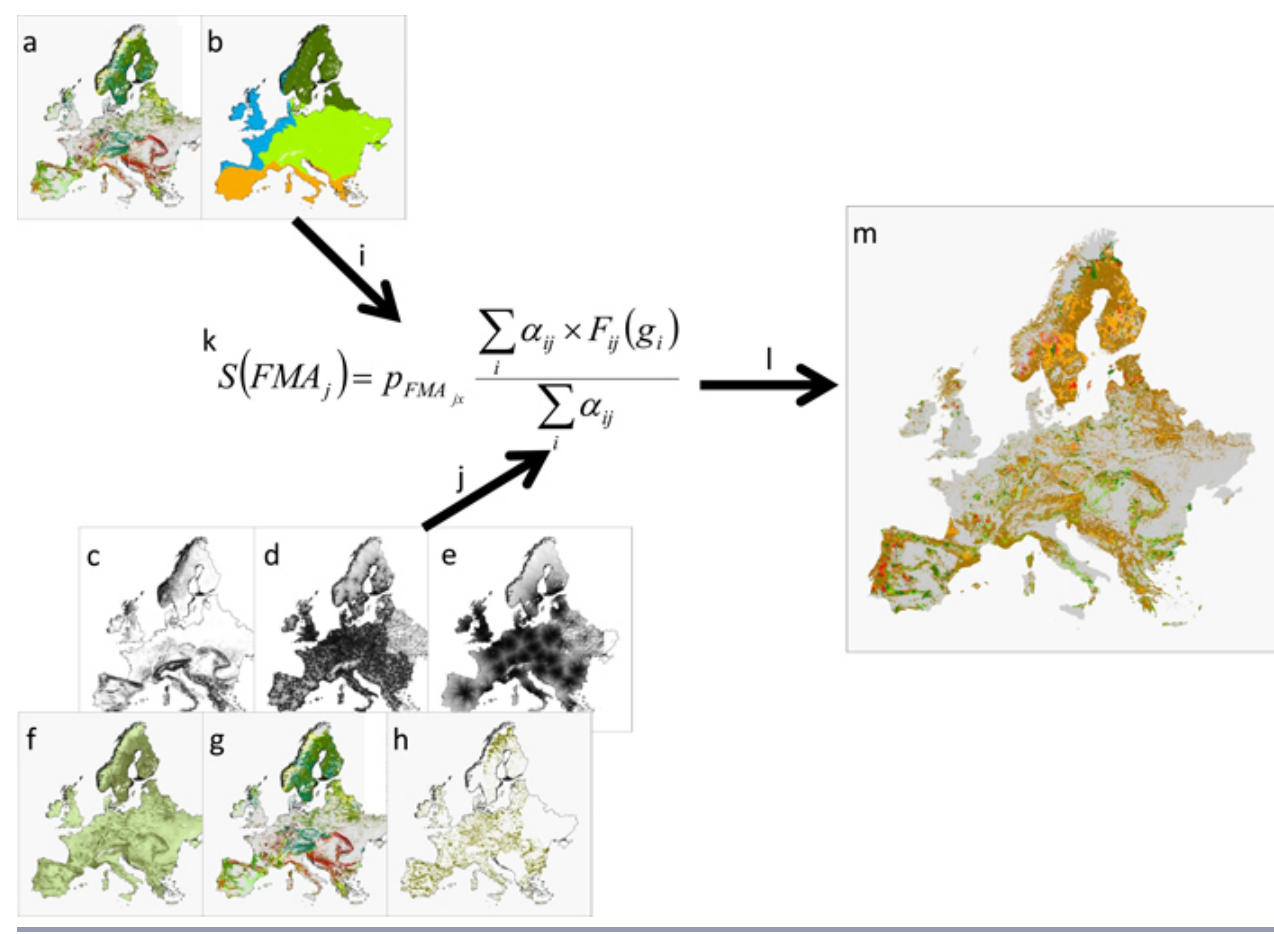
Fig. 1 . Flow chart for compilation of the map of forest management approaches. Schematic representation of how the different (GIS-) data sets were combined using the parameter values of Tables 1 and 2 in Equation 1. Data sets are (a) tree species distribution map, (b) biogeographic regions, (c) slope, (d) proximity to towns larger than 25,000 inhabitants, (e) proximity to cities larger than 750,000 inhabitants, (f) forest cover, (g) stand area derived from the tree species map of Europe, and (h) Natura2000 regions. Arrow (i) combines the biogeographic and species information with the regional species suitability to form pFMA in Equation 1 (k). Arrow (j) combines the data sets (c–h) on factors (gi) with the weighting factors ( a ) from Table 2 in Equation 1. Equation 1 (k) combines the different data sets into a suitability measure for each forest management approach in each stand. Arrow (l) combines these suitabilities into a map of the most suitable forest management approach per square kilometer